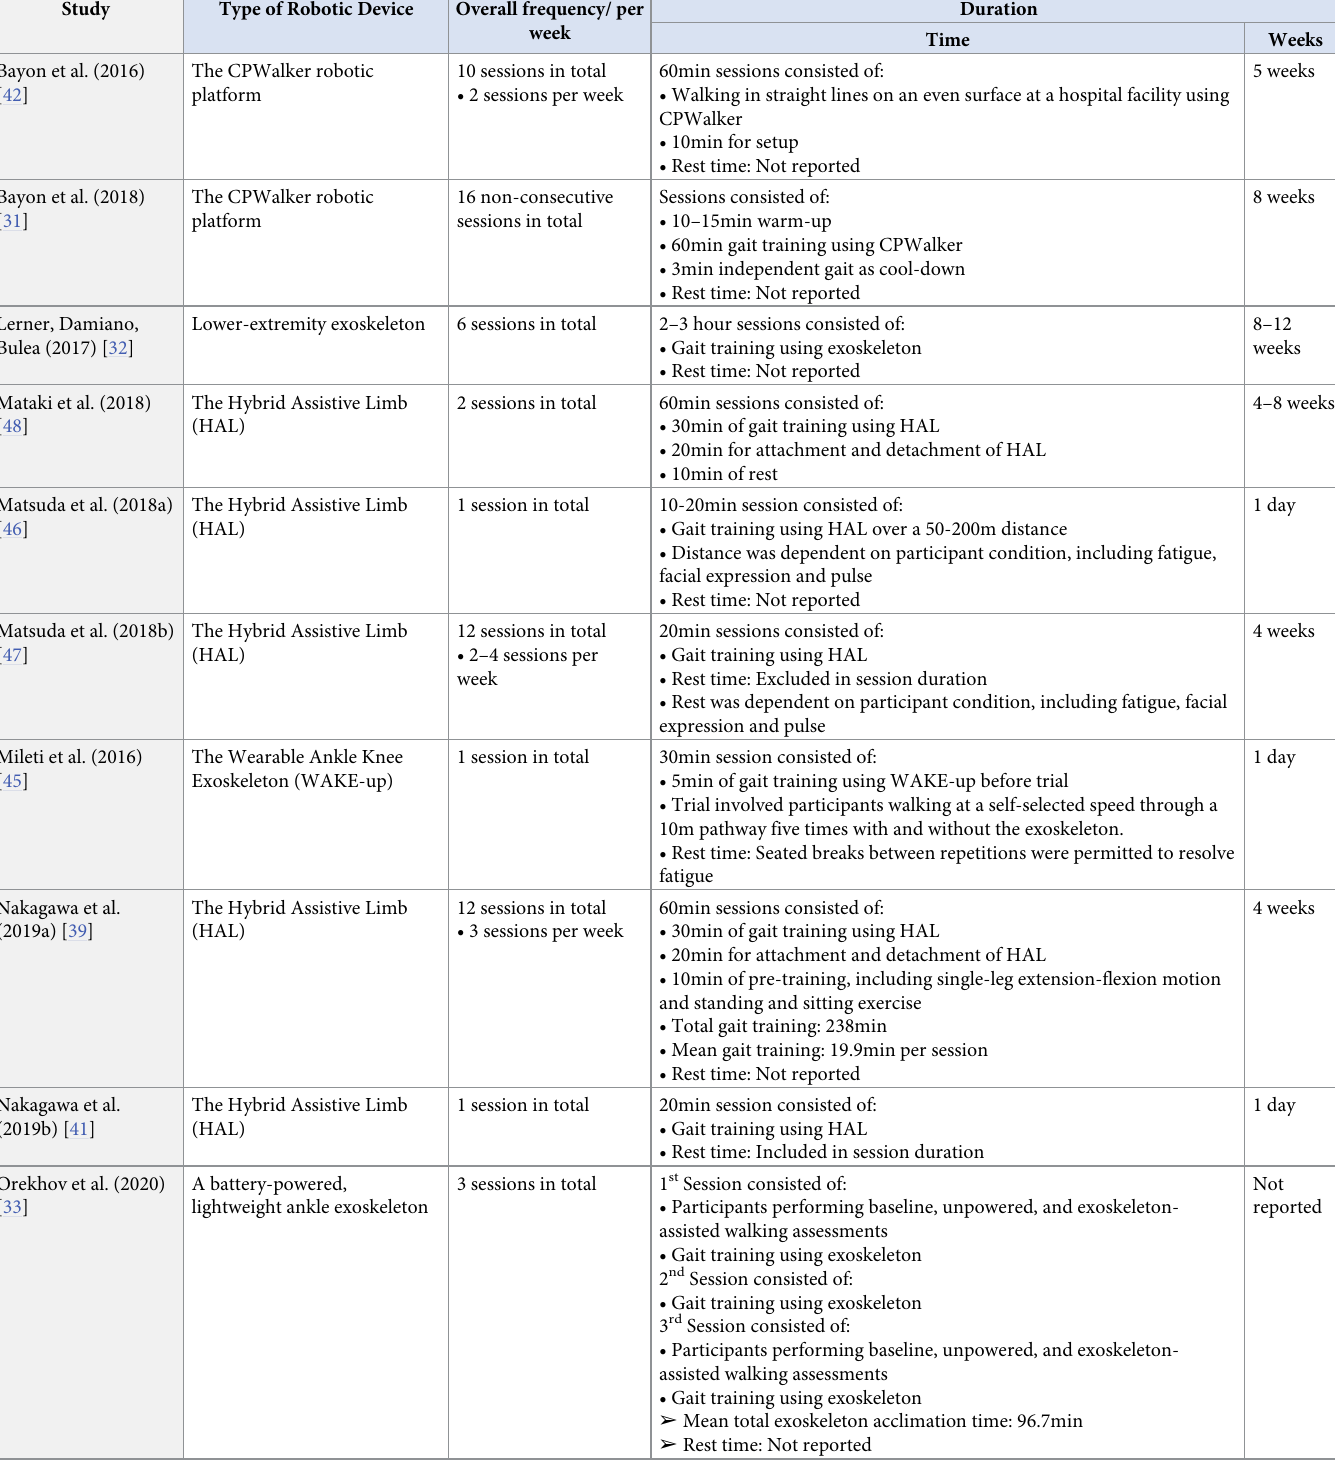
Table 3. Intervention